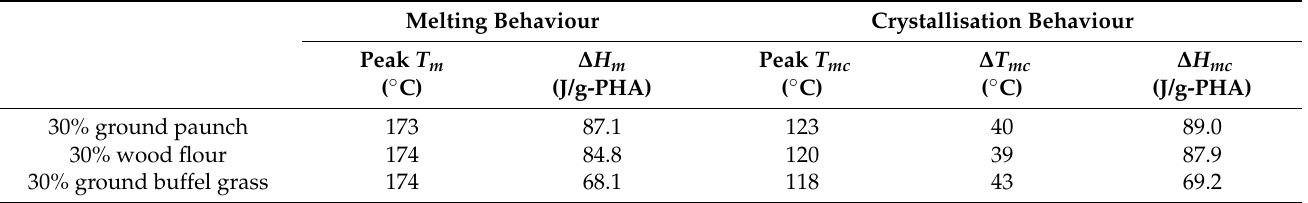
Table 4. Thermal properties for PHBV in PHBV/paunch, PHBV/wood flour and PHBV/buffel grass composites at a fibre content of 30